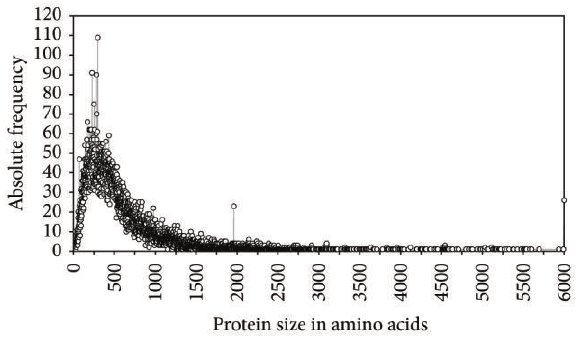
Figure 5: Frequencies of protein sizes for 30800 proteins (Dataset 2).